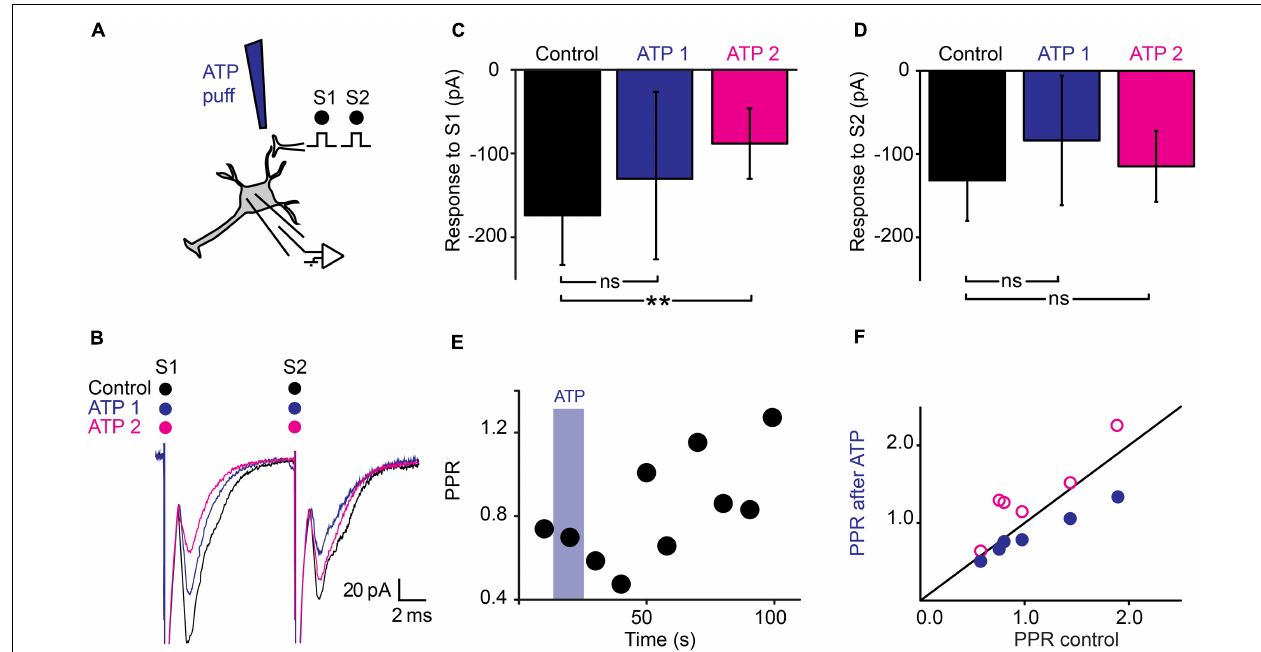
FIGURE 4 | Dual effects of ATP on synaptic transmission. (A) Schema of the principle of the preparation. Ventral horn neuron recorded in whole-cell mode. Synaptic stimulation produced by a bipolar electrode (S1, S2). Puff application of ATP. (B) Response of a ventral horn neuron to two stimulations in control conditions (black), during (ATP 1) and 1 min after puffing ATP (ATP 2) between the stimulation and recording electrode. The amplitude of the first EPSC got more decreased with time while the amplitude of the second EPSC got less decreased. (C) Amplitude of the first EPSC in control condition, during a puff of ATP